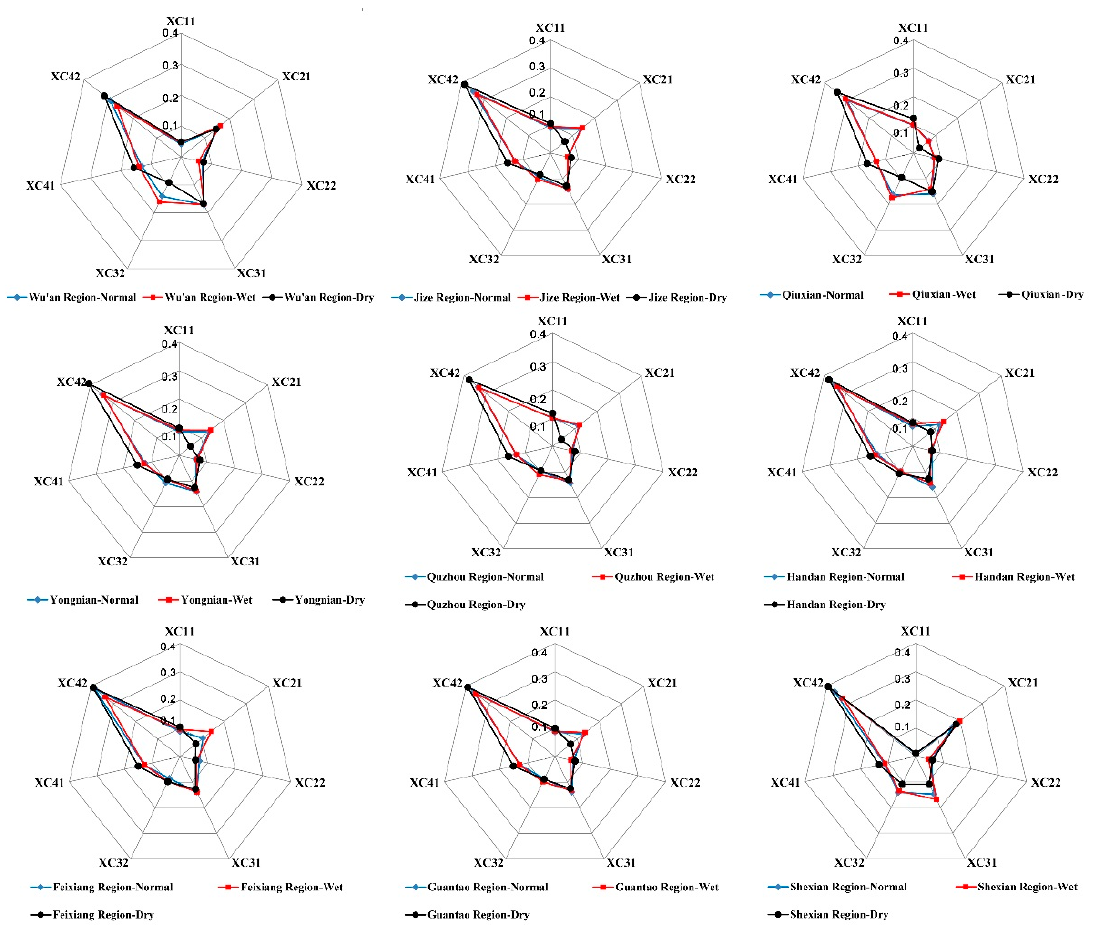
Figure 10. Contribution ratio of different factors to the comprehensive SWA in Wu’an, Jize, Qiuxian, Yongnian, Quzhou, Handan, Feixiang, Guantao, and Shexian regions in different hydrological-level years. As shown in Table 1, the factor of C11 represents the valid physical capacity of the soil reservoir, C21 represents the average value of the annual empty storage capacity of the soil reservoir, C22 is the factor for the average annual variation of the empty storage capacity of the soil reservoir, C31 represents the factor for the temporal matching degree between the soil water supply and crop water demand, C32 represents the factor for the spatial matching degree between the soil water supply and crop water demand, C41 is the factor for the soil water conversion efficiency, and C42 is the factor for the crop use efficiency of the soil water.